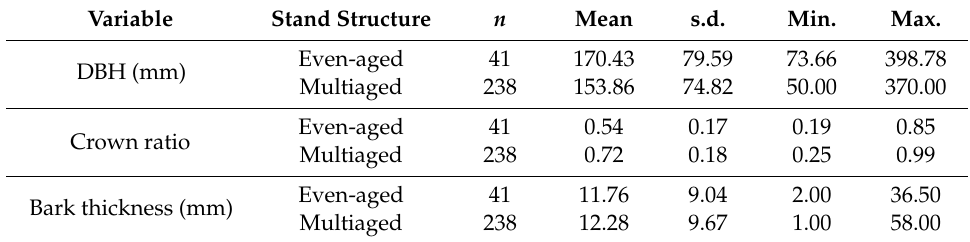
Table 8. Summary data for the redwood trees in even-aged stands versus understory trees in multiaged stands. Data for trees < 400 mm DBH ( n = 279) collected in 32 plots sampling even-aged and multiaged stands in Jackson Demonstration State Forest.